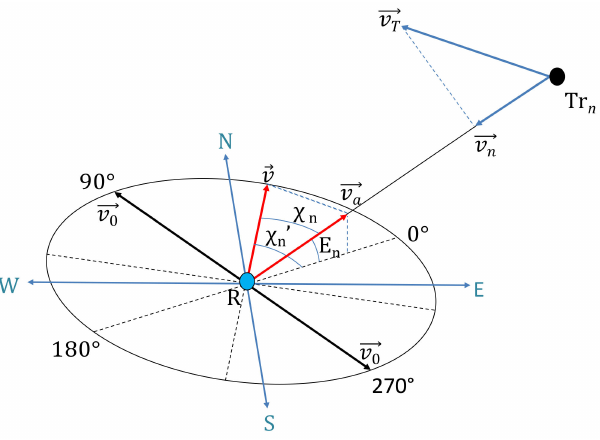
Figure 6. Reference geometry for Doppler shift analysis. Adapted from